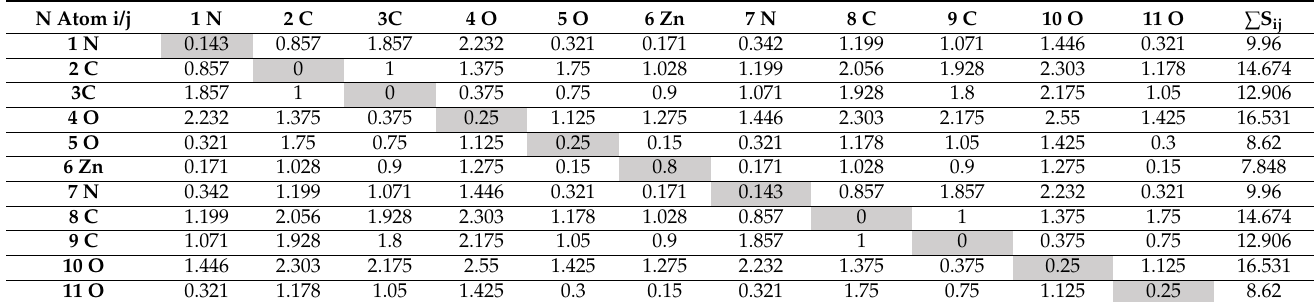
Table 2. Zinc glycinate’s topological matrix for Balaban index